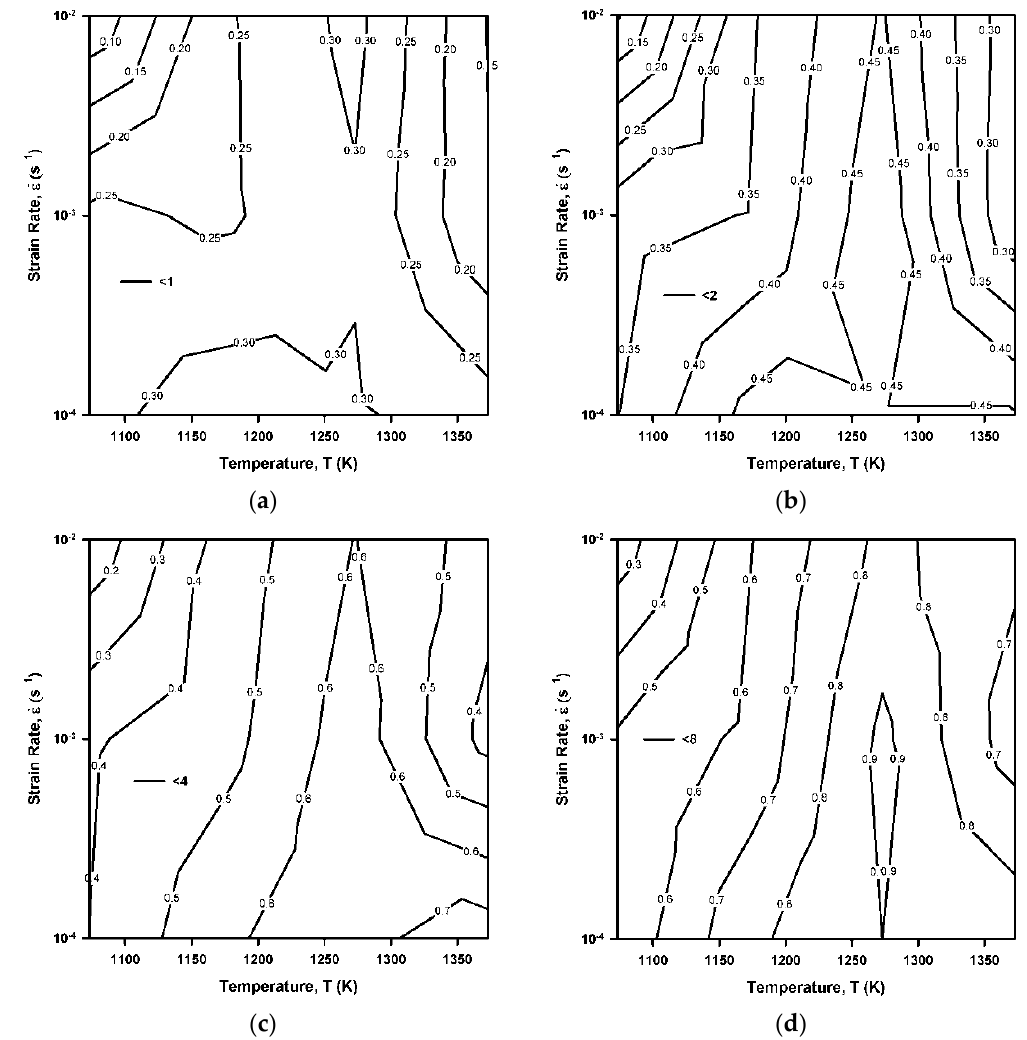
Figure 8. Fraction of grains with the grain orientation spread below 1 ( a ), 2 ( b ), 4 ( c ), and 8 ( d ) in a highly-alloyed austenitic stainless steel subjected to hot compression.